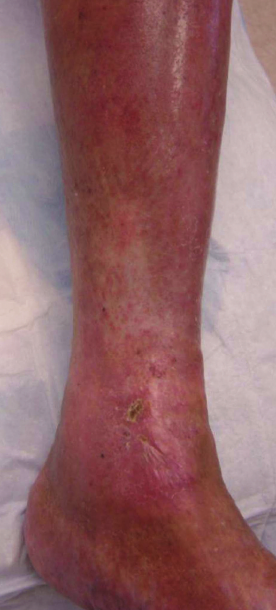
Figure 6: Healing of the skin ulcers following embolization, endo- venous ablation, and